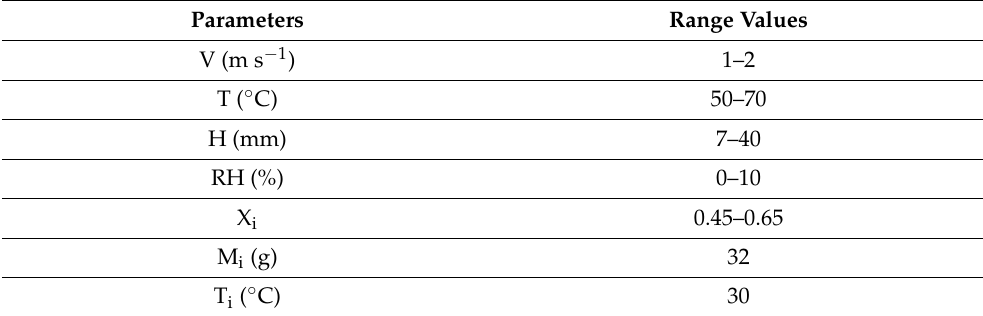
Table 2. Properties of the corn particles used in the experiment.